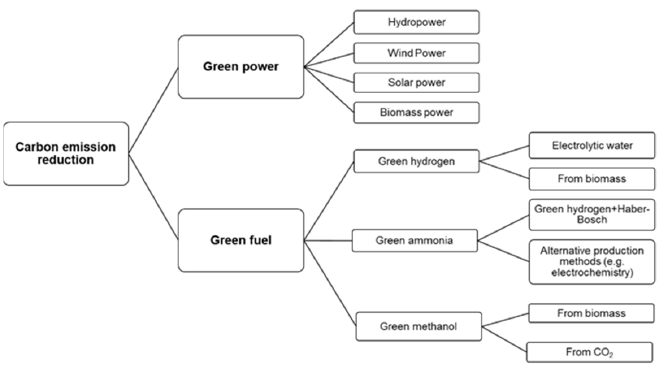
Figure 6. Production methods of green power, green hydrogen, green ammonia, and green metha- nol.